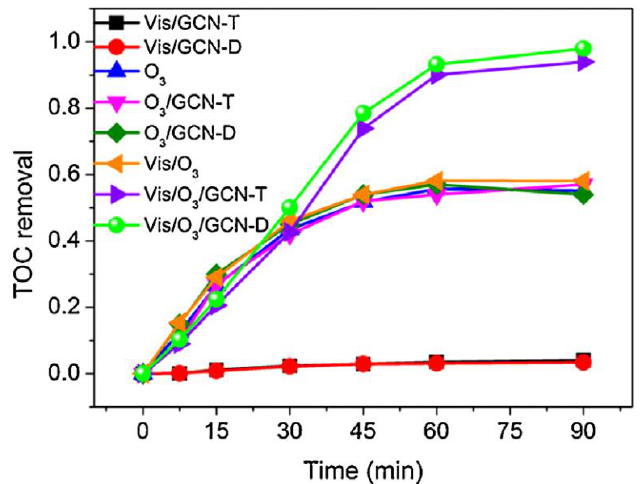
Figure 2. TOC removal of PHBA degradation under ozonation or irradiation under various condi- tions (gas flow rate: 100 mL/min; O 3 concentration: 30 mg/L; light intensity: 365 mW/cm 2 ; initial volume of solution: 400 mL; initial PHBA concentration: 40 mg/L; catalyst dosage: 1 g/L). Repro- duced with permission from ref. [54]. Copyright 2016 Elsevier.